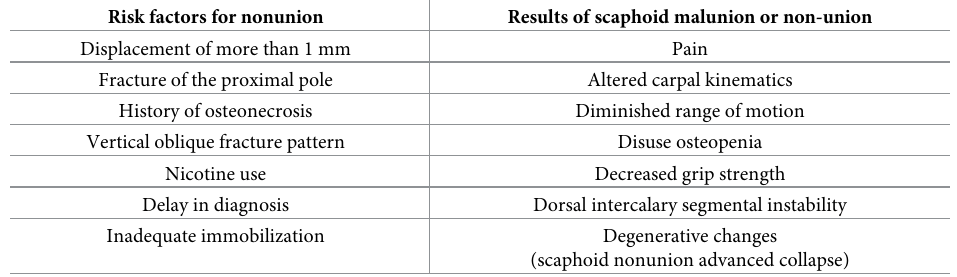
Table 1. Risk factors leading to nonunion scaphoid fractures and nonunion